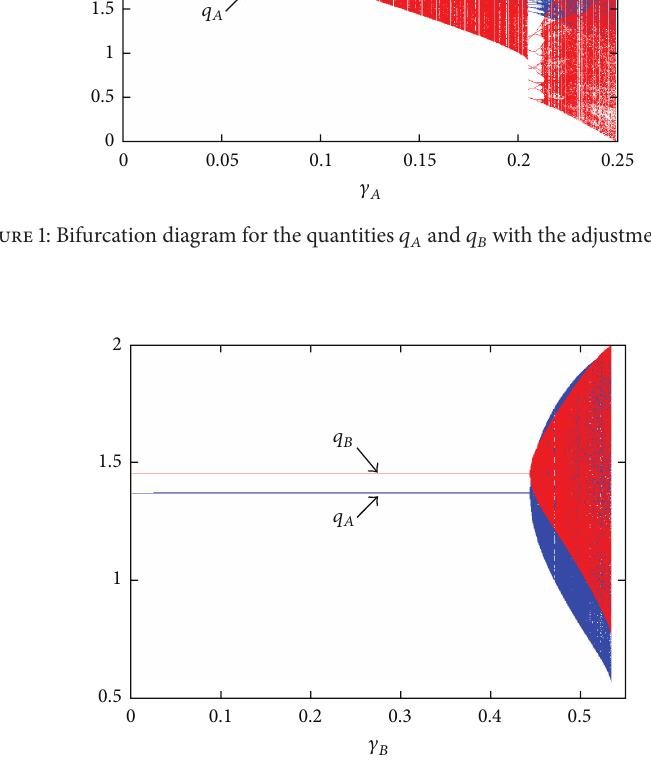
Figure 2: Bifurcation diagram for the quantities 𝑞 𝐴 and 𝑞 𝐵 with the adjustment speed 𝛾 𝐵